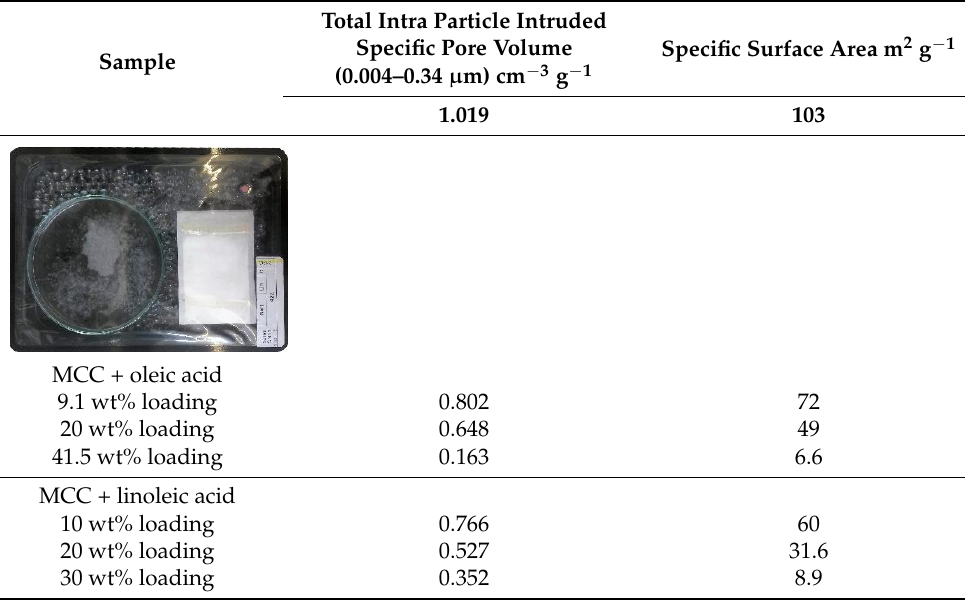
Table 1. Intra particle pore volume and specific surface area of loaded and unloaded MCC. Mean values (n = 2).